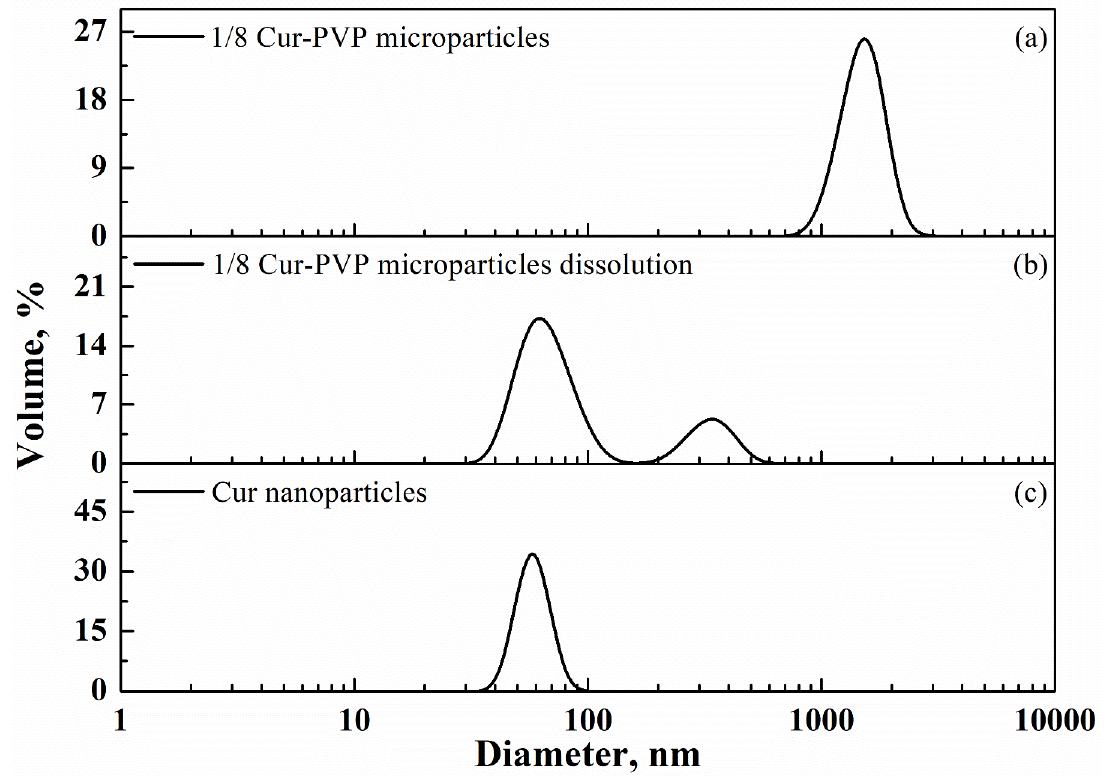
Figure 6. DLS traces of: ( a ) starting 1/8 Cur-PVP microparticles, ( b ) 1/8 Cur-PVP microparticles dissolution, ( c ) final Cur nanoparticles. The samples were tested every 5 min, and only the most significant results are reported in this figure.